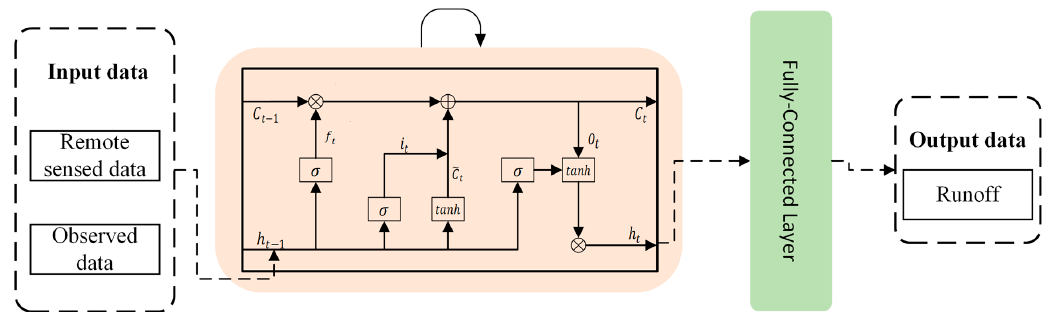
Figure 3. Architecture of the fully connected LSTM. The dashed black box at the beginning indicates the input sample features of the model. The pink box represents the LSTM layer in the model. The green box indicates adding a fully connected layer to the LSTM layer. The last dashed black box corresponds the simulated data of the model.